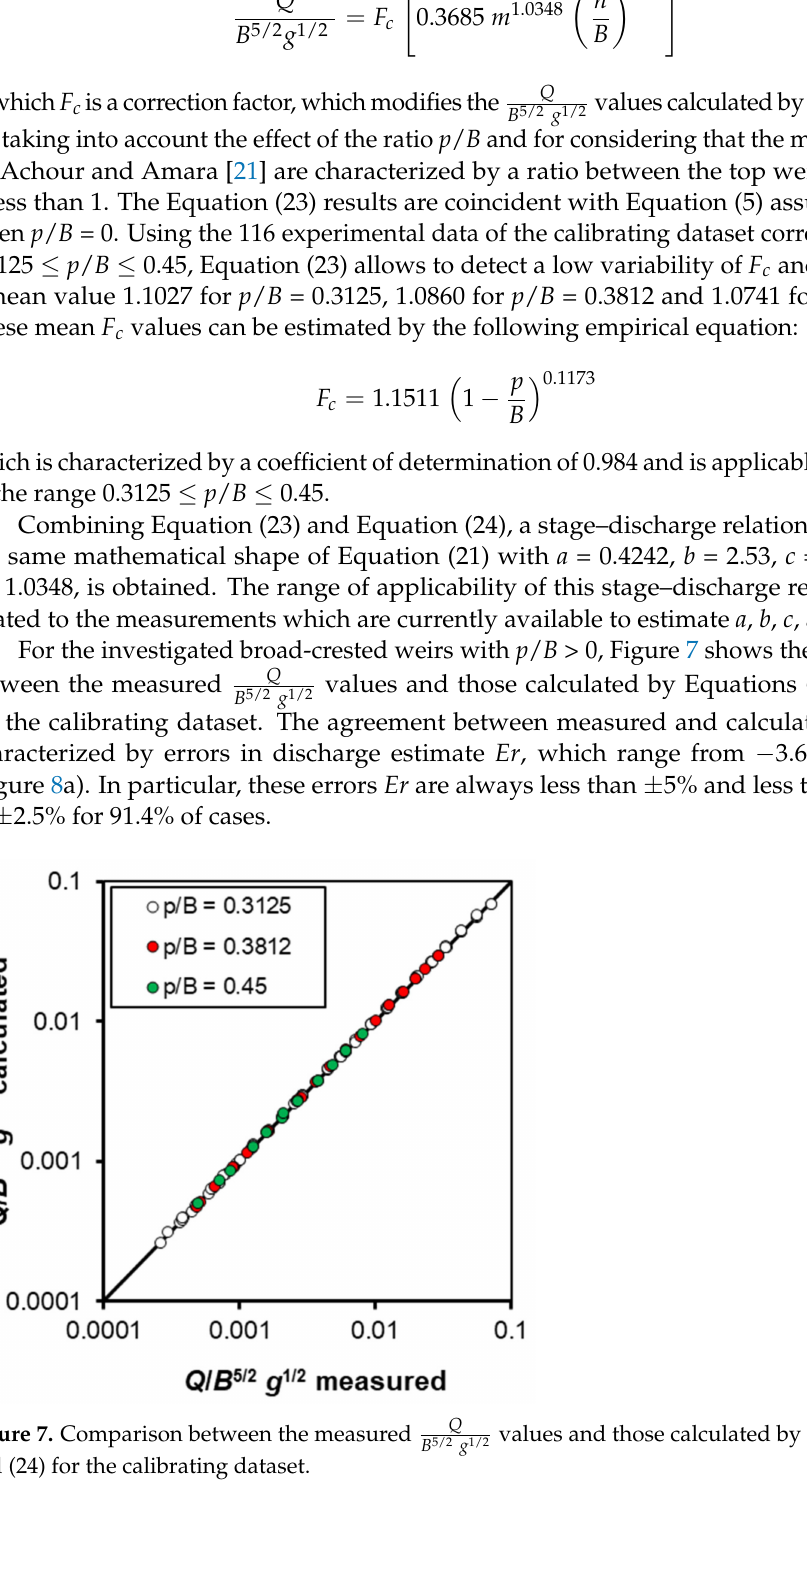
values and those calculated by Equations (23) B 5/2 g 1/2